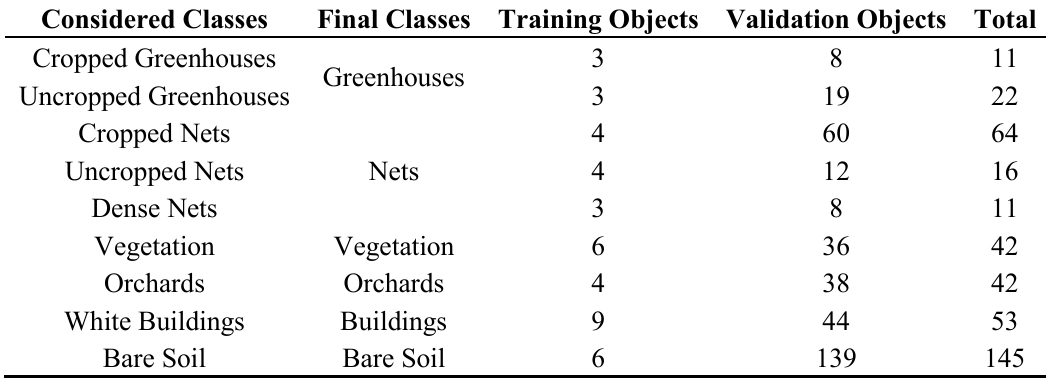
Table 2. Characteristics of WV2 and GE1 stereo pairs acquired at the study